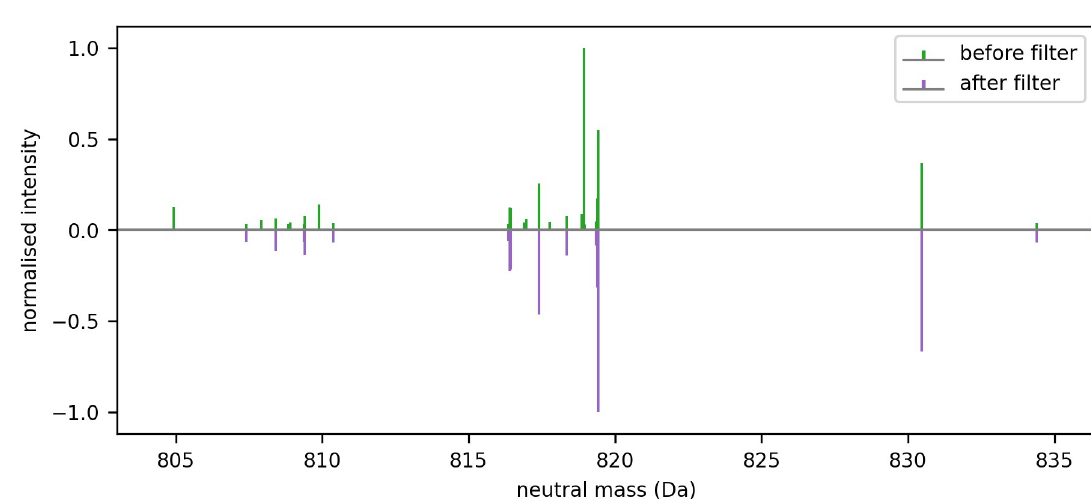
Fig 14. An enlarged segment of the neutral mass axis showing some examples of fragment ions being removed if they did not occupy a mass defect window.